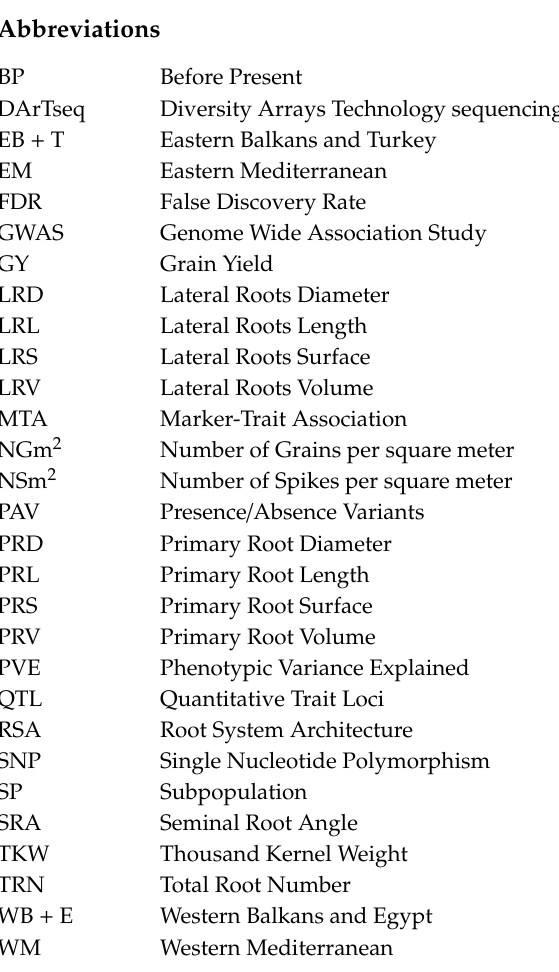
Table S1: Accessions included in the study, Table S2: Statistics of the seminal RSA traits, Table S3: Means comparison of seminal root system architecture traits for the eastern Balkans (EB) and Turkish durum wheat landraces. Means within columns with di ff erent letters are significantly di ff erent at p < 0.05 following a Tukey test, Table S4: Linkage disequilibrium decay plots. (A) Genome A. (B) Genome B. The LOESS curve is represented in blue. The horizontal red line corresponds to the r 2 mean for each genome, Table S5: Significant markers associated with seminal root system architecture traits obtained in 160 durum wheat Mediterranean